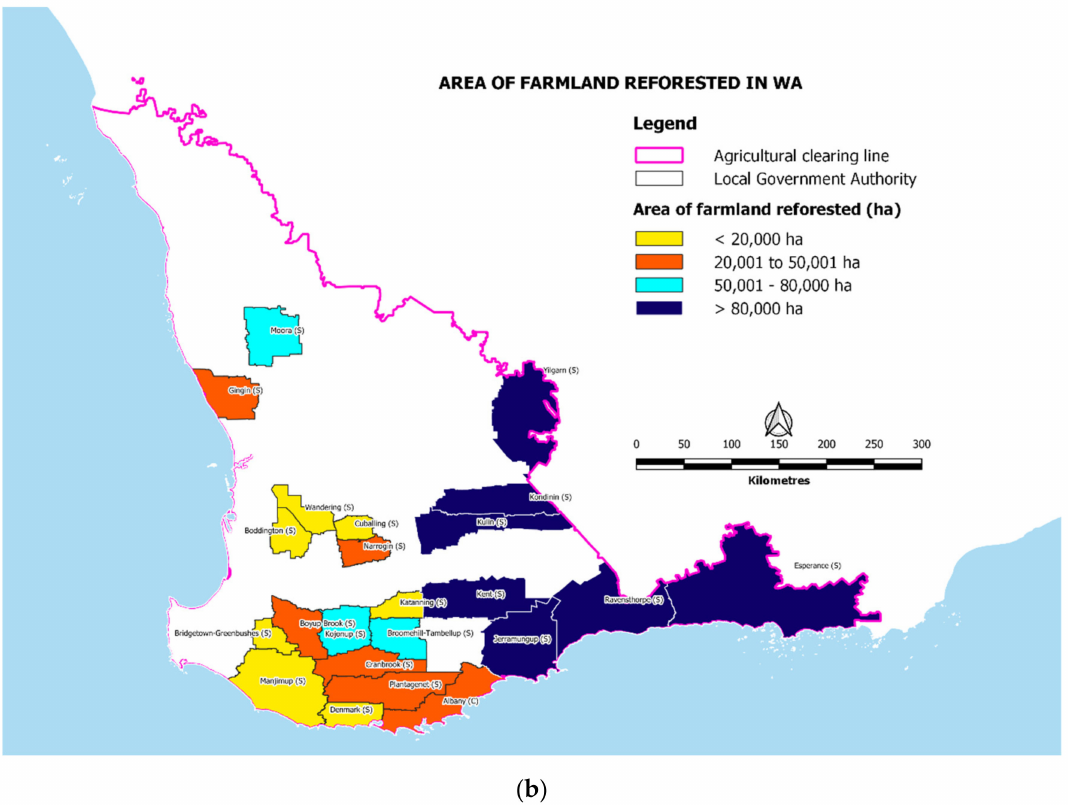
Figure 5. Area of farmland in various shires selected for reforestation under two scenarios; top ( a ) no decline in agricultural emissions towards 2050 and tree growth reduces by 15% and a greater risk of wildfire, and bottom ( b ) agricultural emissions decline by 20% towards 2050 and tree growth reduces by 10% and risk of wildfire